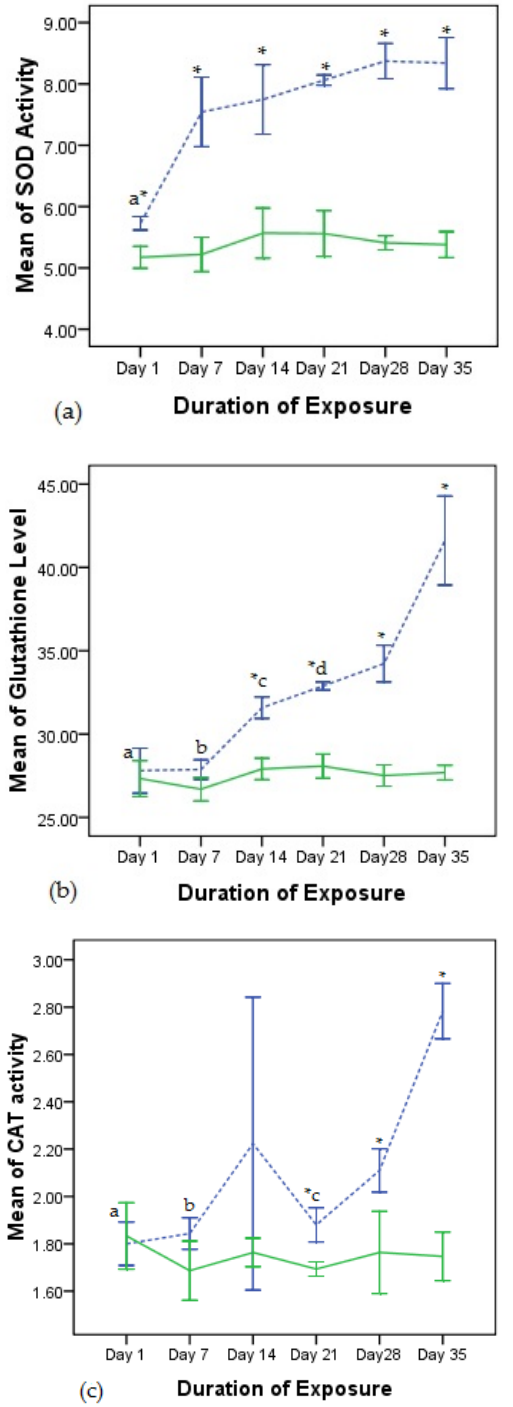
Figure 1. Line graph of antioxidant activity in exposed rats compared to controls, data represent the mean and standard deviation of five rats, broken line indicates exposed rats while the continuous line indicates control; * indicates significant difference between exposed rats and control ( p < 0.05): ( a ) Superoxide dismutase SOD activity (U/L), ‘a’ indicates significant difference compared to day 7, 14, 21, 28 and 35; ( b ) Glutathione activity (U/L), ‘a’ and ‘b’ indicate significant differences compared to day 14, 21, 28 and 35, ‘c’ and ‘d’ indicate significant differences compared to day 35 ; ( c ) Catalase activity (U/L), ‘a’, b’ and ‘c’ indicate significant differences compared to day 35.